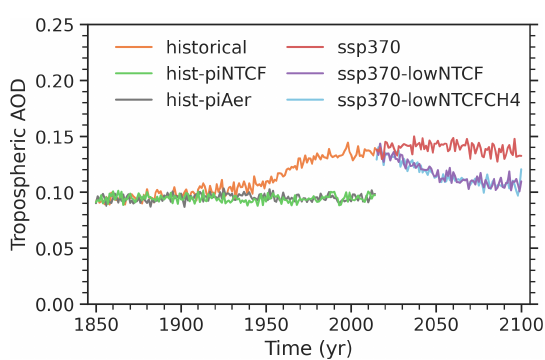
Figure 10. Annual global mean tropospheric aerosols optical depth (AOD) at 550nm in the simulations presented in Fig.